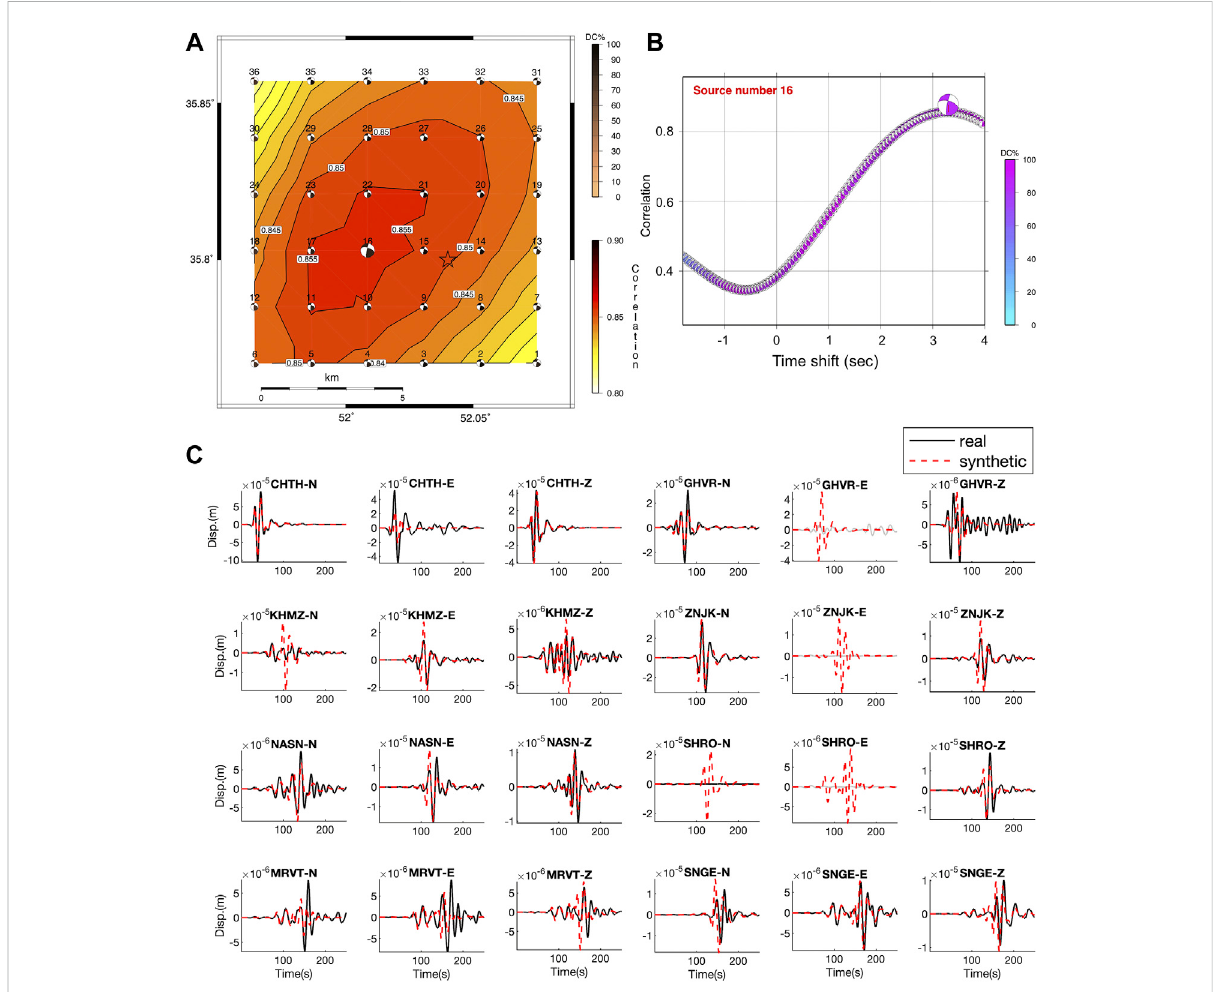
FIGURE 2 3D grid search of the M5.1 mainshock centroid location-time. (A) Horizontal slice on the space-time correlation plot of trial centroid point sources at a depth of 12 km. The best result was obtained for source number 16 (the larger focal mechanism) with a correlation of 85% situated almost 4 km WNW of the hypocenter reported by IRSC (black star). (B) Centroid time correlation plot for the preferred point source #16. The best centroid time is shifted 3.3 s with respect to the IRSC reported origin time. (C) Waveform fi t between the real (solid) and synthetic (dashed) displacements for the best obtained moment tensor. Station names and components are written on the top of each sub- fi gure. Gray waveforms were not used in the inversion, while the related synthetics were produced by forward